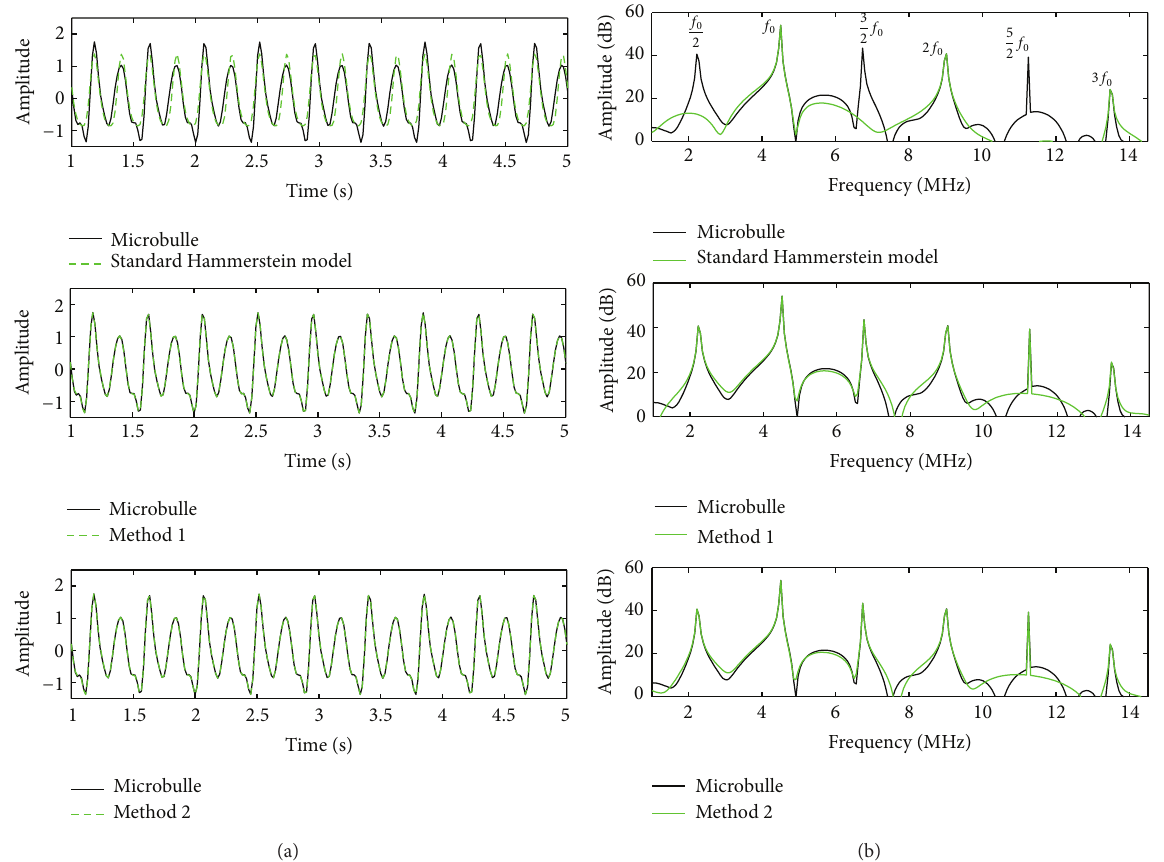
Figure 6: (a) Comparison between the signal backscattered by the contrast agent 𝑦(𝑛) (in black) and its estimation ̂𝑦(𝑛) (in green): the signal modeled with (top) the standard Hammerstein model, (middle) method 1, and (bottom) method 2. (b) Spectra of different signals presented in (a). Here SNR = ∞ dB.